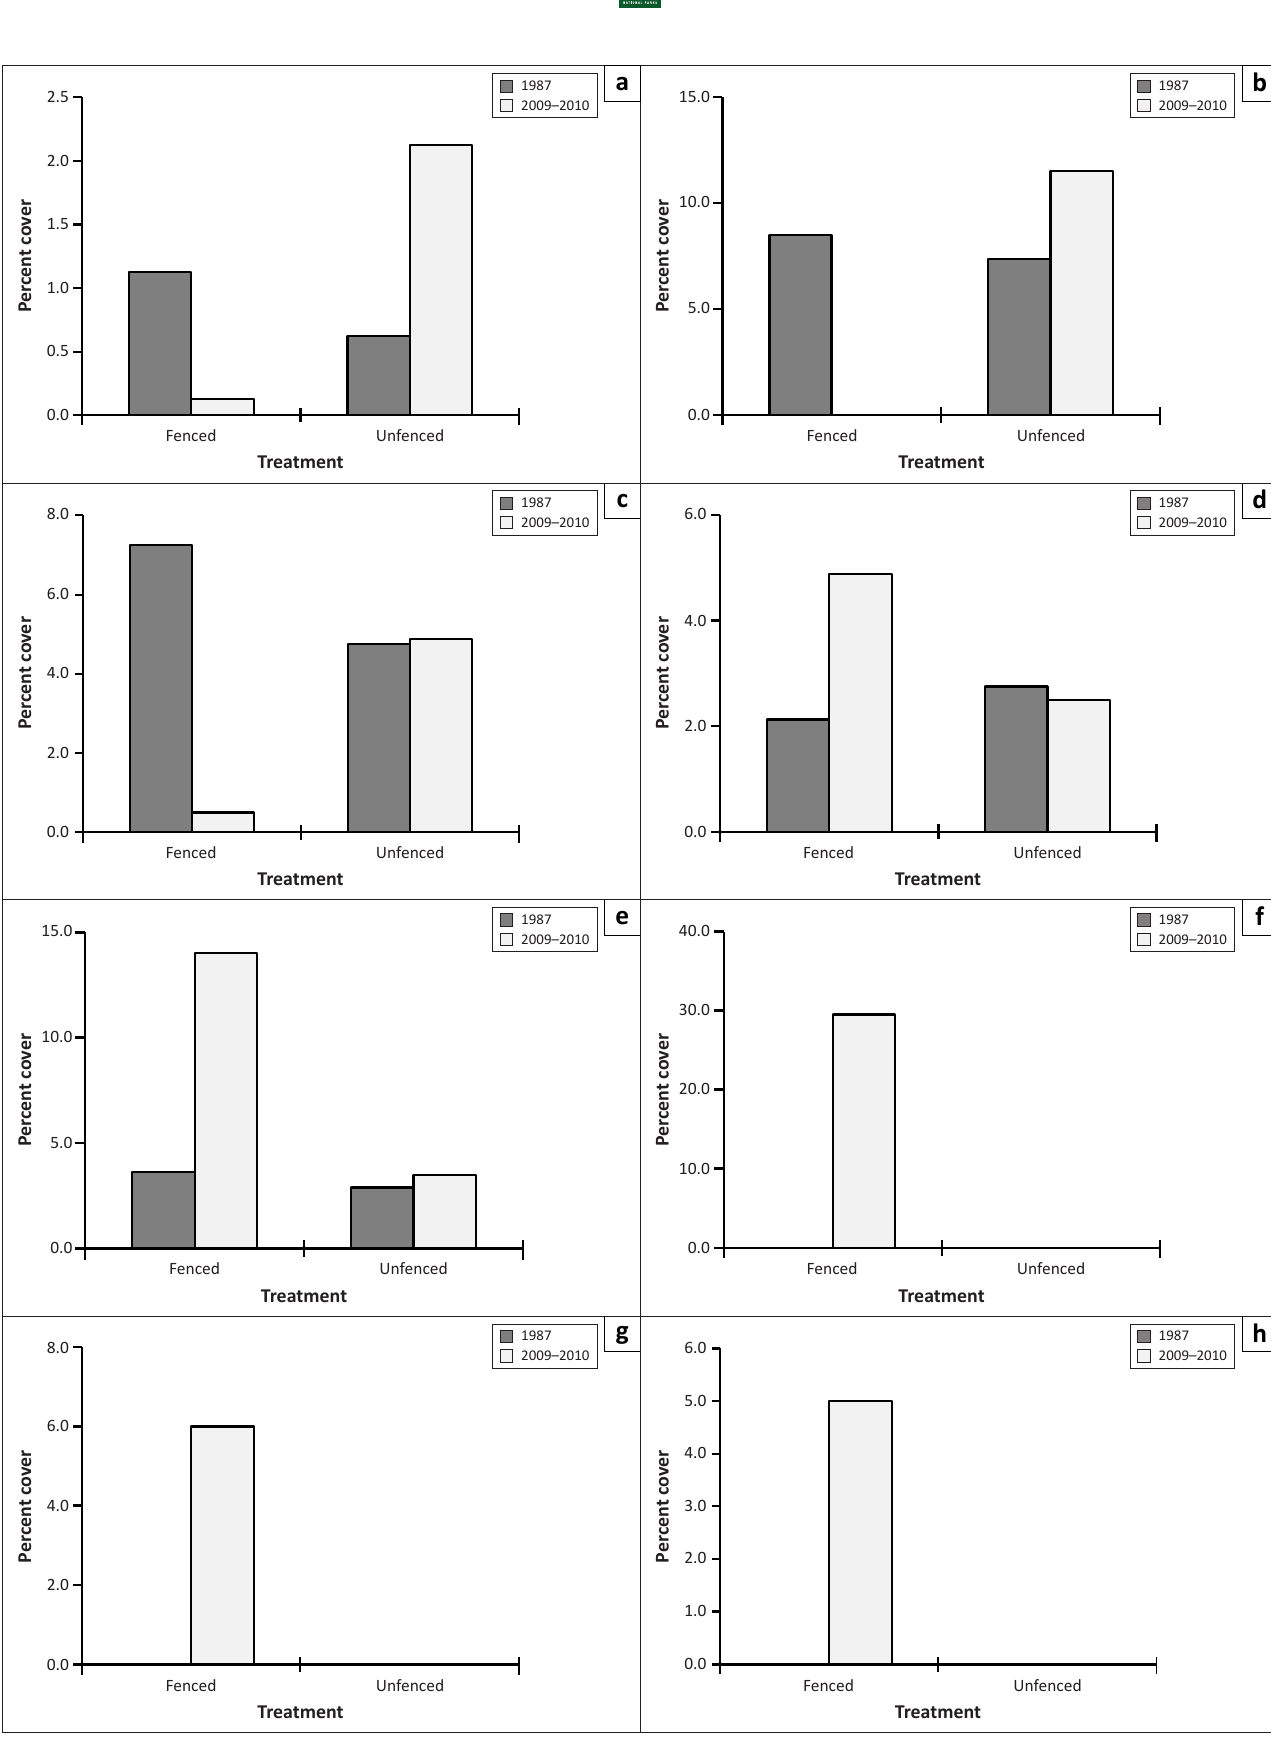
FIGURE 1: Mean percentage canopy cover of the most common grass species in four pairs of plots compared between 1987 and 2009–2010 for fenced and unfenced plots: (a) Aristida congesta (annual grass), (b) Cynodon incompletus (creeping grass), (c) Tragus koelerioides (creeping grass), (d) Eragrostis curvula (bunch grass), (e) Digitaria eriantha (bunch grass), (f) Themeda triandra (bunch grass), (g) Cymbopogon pospischilii (bunch grass) and (h) Heteropogon contortus (bunch